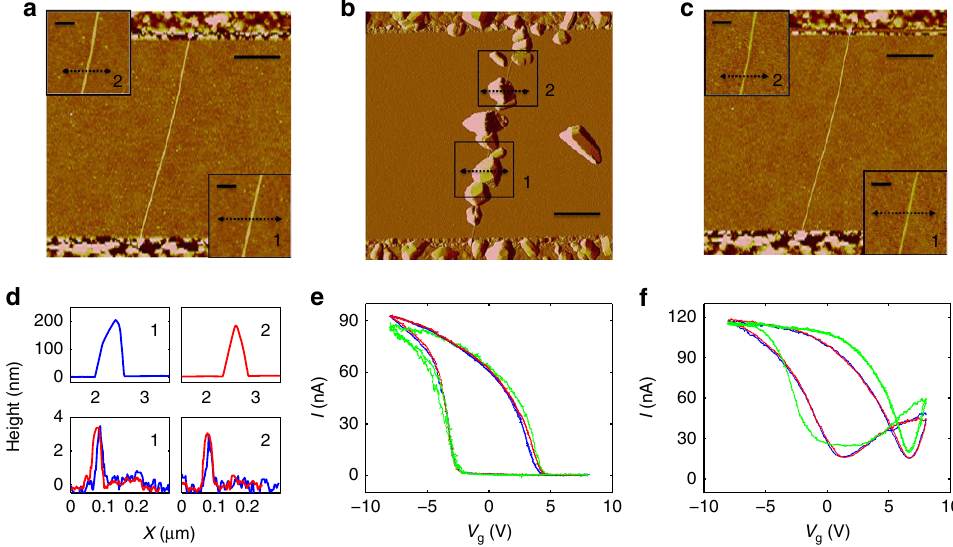
Figure 3 | Electrical characterization of marked and non-marked carbon nanotubes. ( a – c ) AFM images of complete carbon nanotube (CNT) device with metallic source and drain electrodes, before p -nitrobenzoic acid ( p NBA) deposition ( a ) immediately after ( b ) and after one day ( c ). Zoom in on the black square areas marked 1 and 2 of the main panel of b are shown as four insets before deposition ( a ) and after one day ( c ). The dotted lines mark the locations of the cross sections which are plotted in d . The scale bar of the main panels, ( a – c ) is 1 m m, and for the insets is 200nm. ( d ) Cross sections along the black dotted lines of panels ( a – c ) of area 1 (left) and area 2 (right). Top panels depict the nanocrystals (NCs) height immediately after deposition (blue for area 1, and red for area 2). Bottom panels plot the CNT diameter before (blue) and long after (red) within area 1 (left) and area 2 (right). ( e , f ) Transfer characteristic of two CNT devices before deposition (blue), immediately after deposition along the CNT (green), and after cleaning process (red).